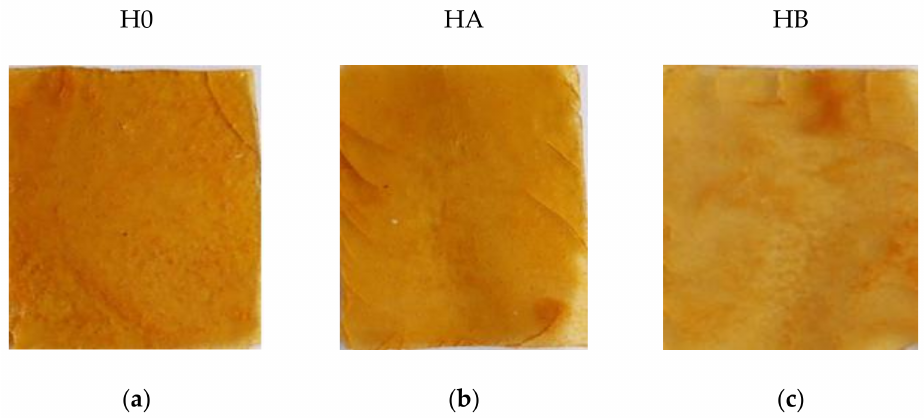
Figure 12. Pictures of compositions with fillers: H0 ( a ); HA ( b ); and HB ( c ); (private photo resources, CanonScan